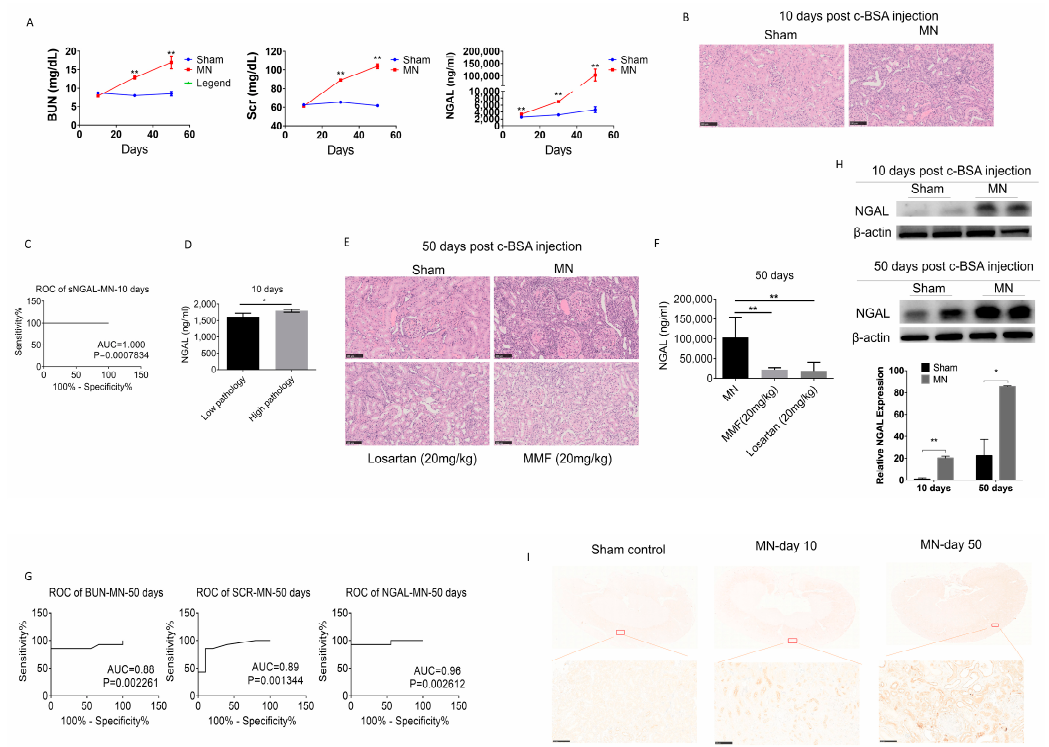
Figure 5. Serum NGAL accurately predicted kidney injury in c-BSA-induced membranous nephropathy. ( A ) Comparisons of BUN, Scr, and sNGAL between the MN model and control after c-BSA injection at three time points. ( B ) Histopathological injuries were evident in the MN model 10 days post c-BSA injection. ( C ) ROC of sNAGL at day 10 after c-BSA injection. ( D ) sNGAL in rats with low-grade pathology was significantly lower than rats with high-grade pathology. ( E ) Histopathological injuries were more evident in the MN model 50 days after c-BSA injection, and MMF and losartan can reduce the renal pathological injuries. ( F ) MMF and losartan treatment remarkably reduced sNGAL in MN rats. ( G ) Comparisons of ROCs of BUN, Scr, and sNGAL between the MN model and control 50 days post BSA injection. ( H ) NGAL protein levels in kidney tissues by western blot at day 10 and day 50 after c-BSA injection. ( I ) Representative immunohistochemistry pictures of NGAL at day 10 and day 50 after c-BSA injection. *, p < 0.05, **, p < 0.01 ( n = 8 for each